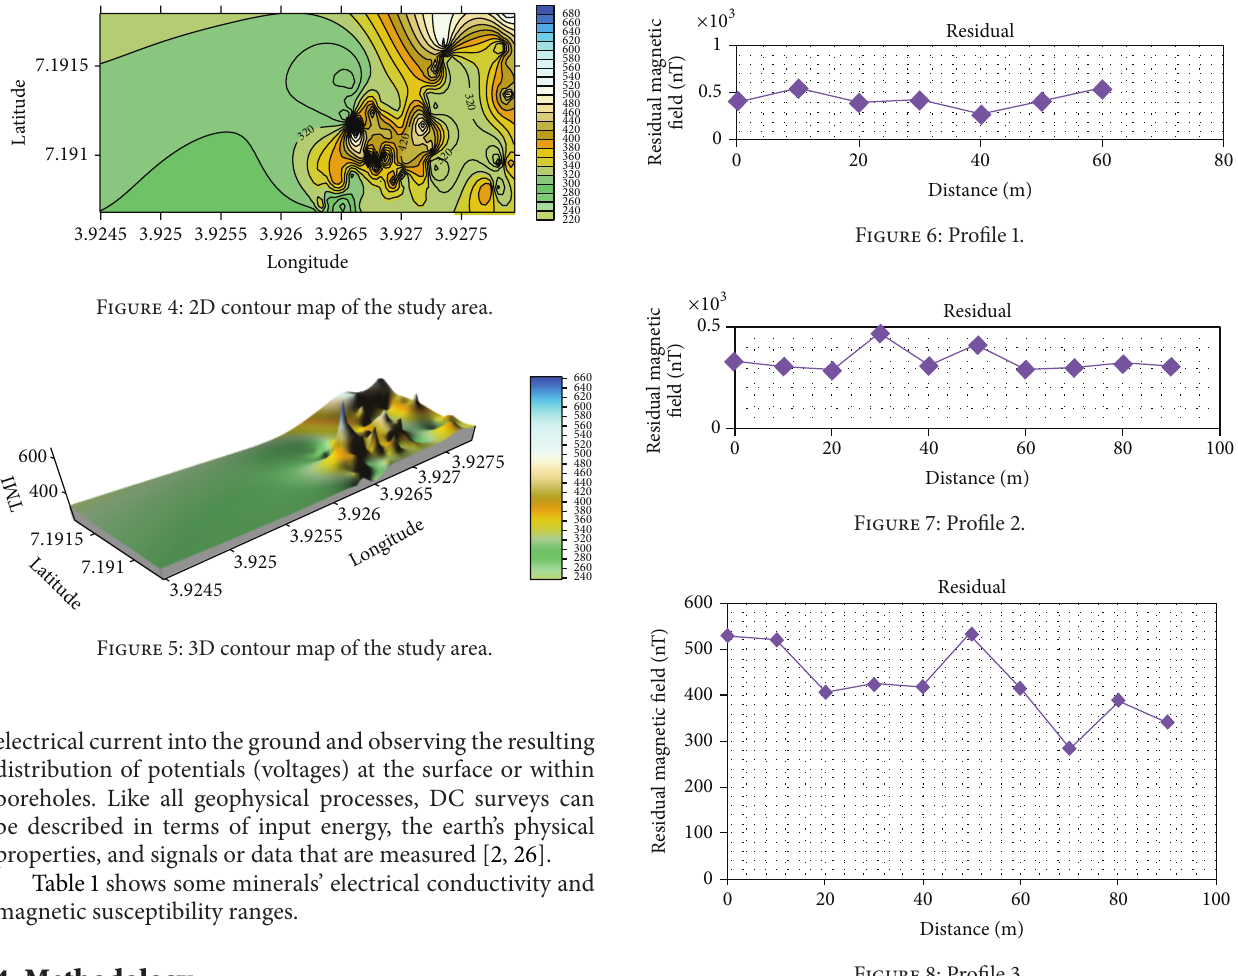
Figure 8: Profile 3.